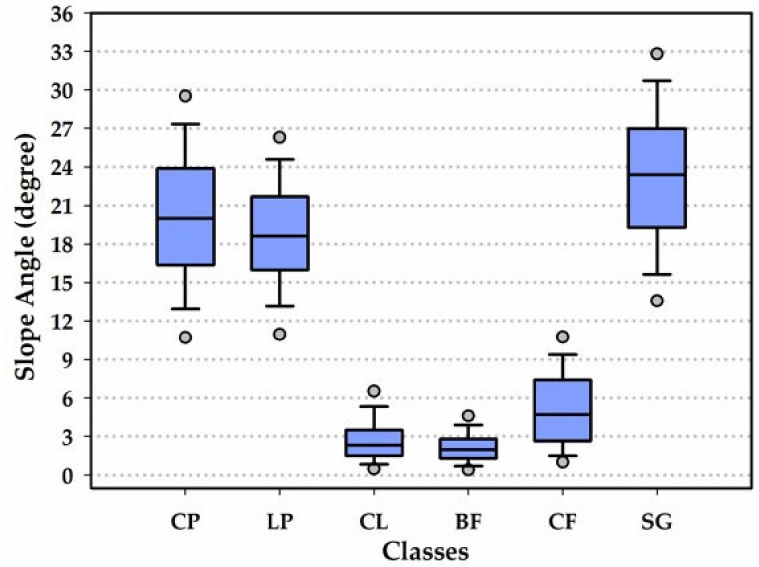
Figure 7. The boxplots of different land cover types for slope